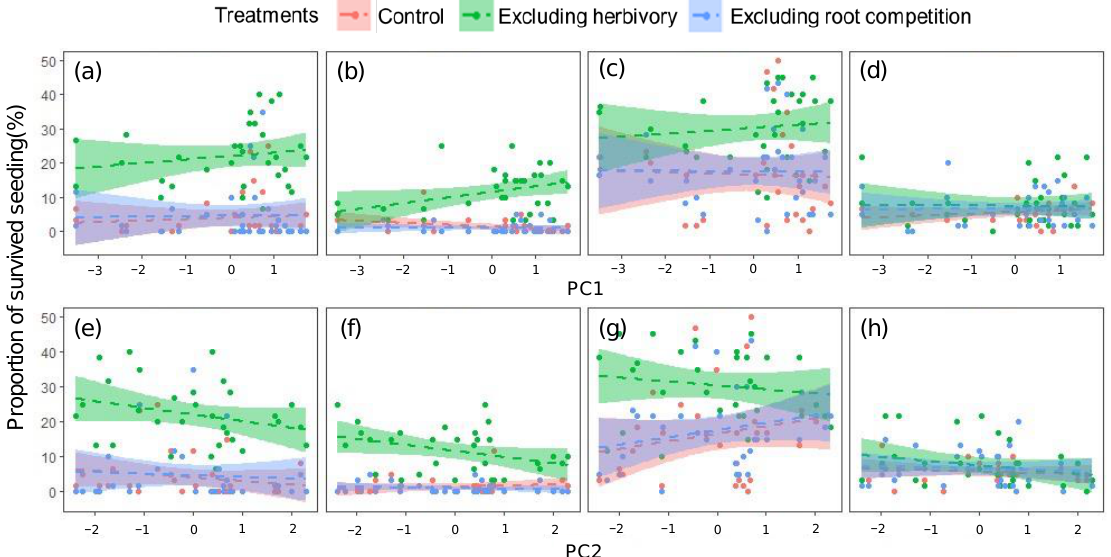
Figure 5. Relationships between the proportion of surviving seedlings and PC1 and PC2 for Cin- namomum camphora ( a , e ), Cyclobalanopsis glauca ( b , f ), Loropetalum chinense ( c , g ), and Schima superba ( d , h ). The dotted lines and shading are the best fit linear regressions and the 95% confidence intervals around the regressions.